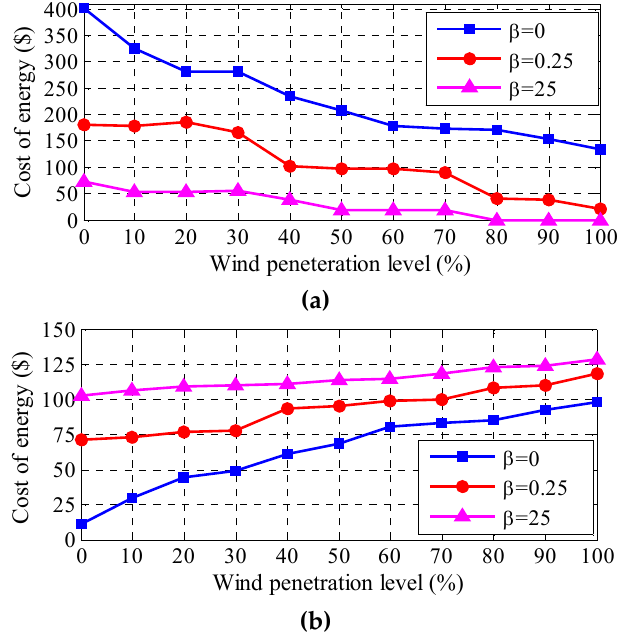
Figure 6. Cost of trading energy versus wind penetration level ( a ) buying from main grid; ( b ) selling to the main grid.